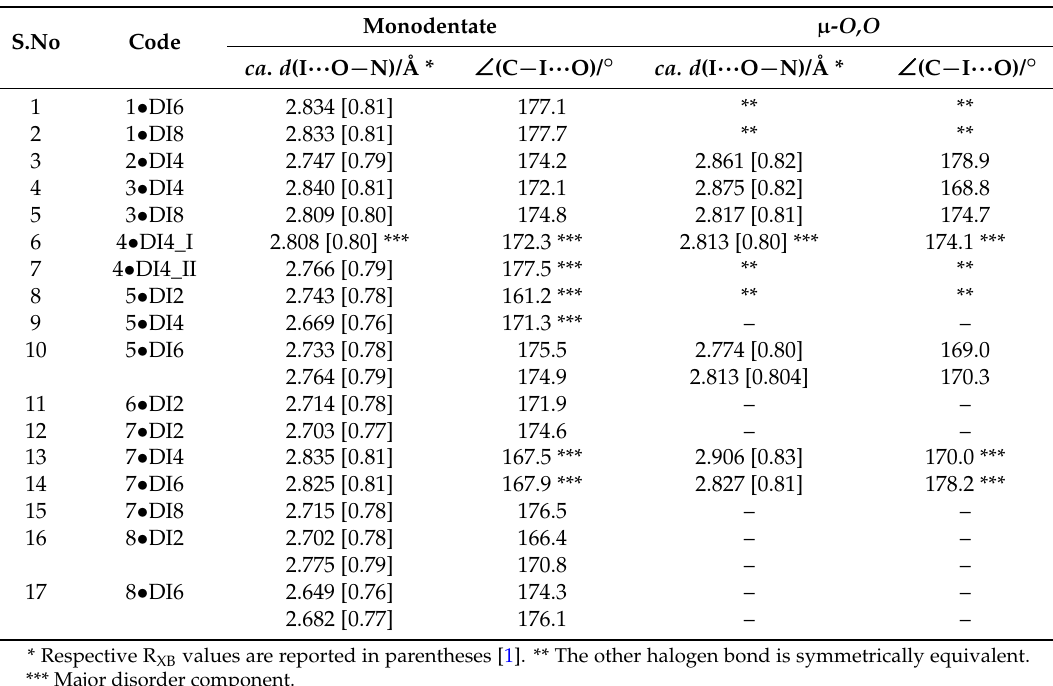
Table 1. Bond parameters for co-crystals 1 • DI6–8 • DI6.